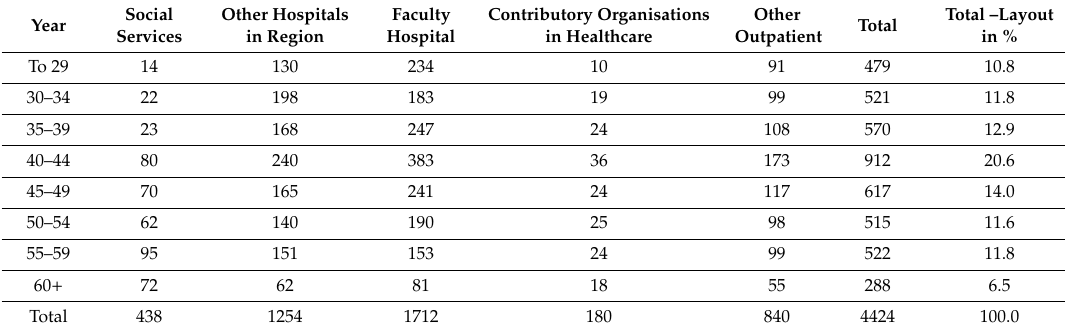
Table 5. Age groups of the nurses in the Hradec Kralove region (HKR).